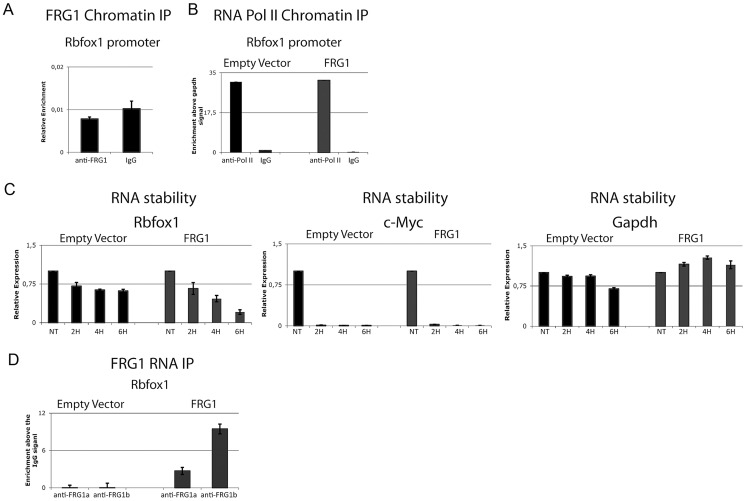
FRG1 regulates the stability of the Rbfox1 mRNA.(a) ChIP of FRG1 in the promoter region of the Rbfox1 gene. (b) The distribution of RNA pol II on C2C12-EV and C2C12-FRG1 cells in the promoter region of the Rbfox1 gene. (c) Real-time RT-PCR of the kinetics of Rbfox1, c-Myc and Gapdh expression after 8 hours of ActD (Actinomycin D) treatment on C2C12-EV and C2C12-FRG1 cells. (d) RNA-IP experiment on samples from (c) using anti-FRG1 antibodies or control IgG antibodies. Immunoprecipitated material was analyzed by real-time RT-PCR, normalized versus the relative input and plotted as fold enrichment versus the IgG. RT-minus control experiments showed the absence of DNA contamination (data not shown).